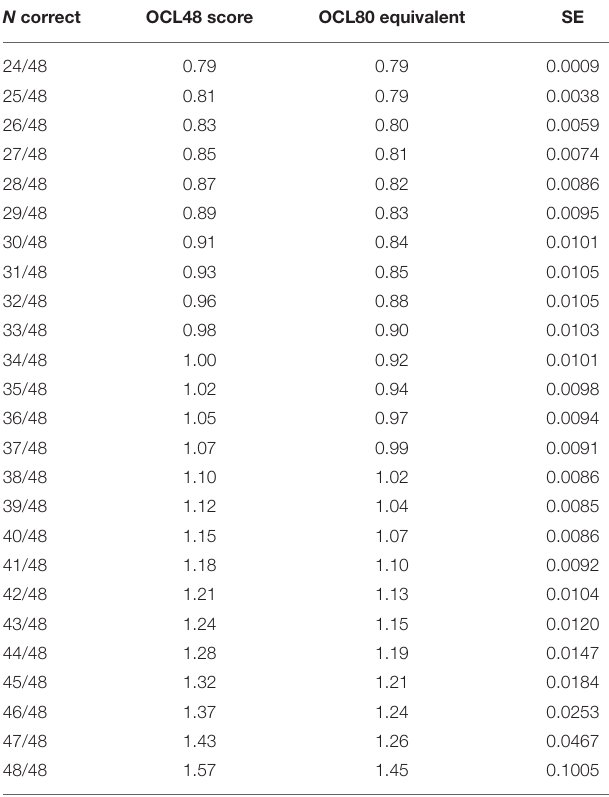
TABLE 4 | OCL48 scores and their OCL80 equivalent, estimated with equipercentile